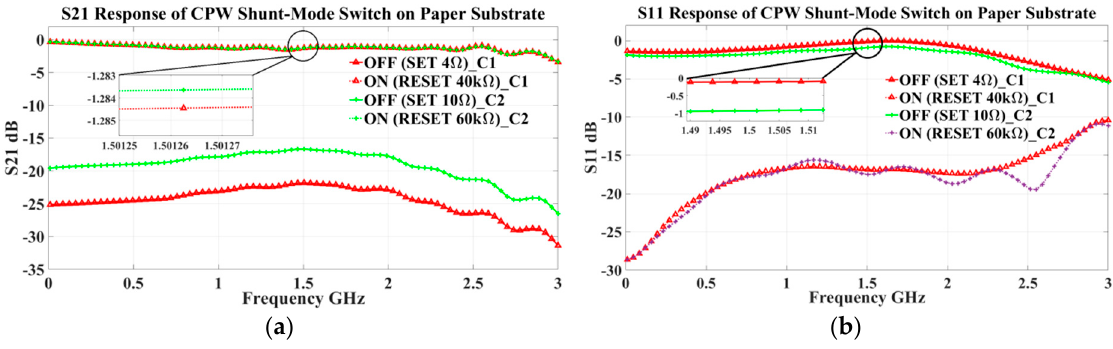
Figure 6. RF-response of the Co-Planar Waveguide (CPW) shunt mode switch on paper substrate. ( a ) S21; ( b ) S11.